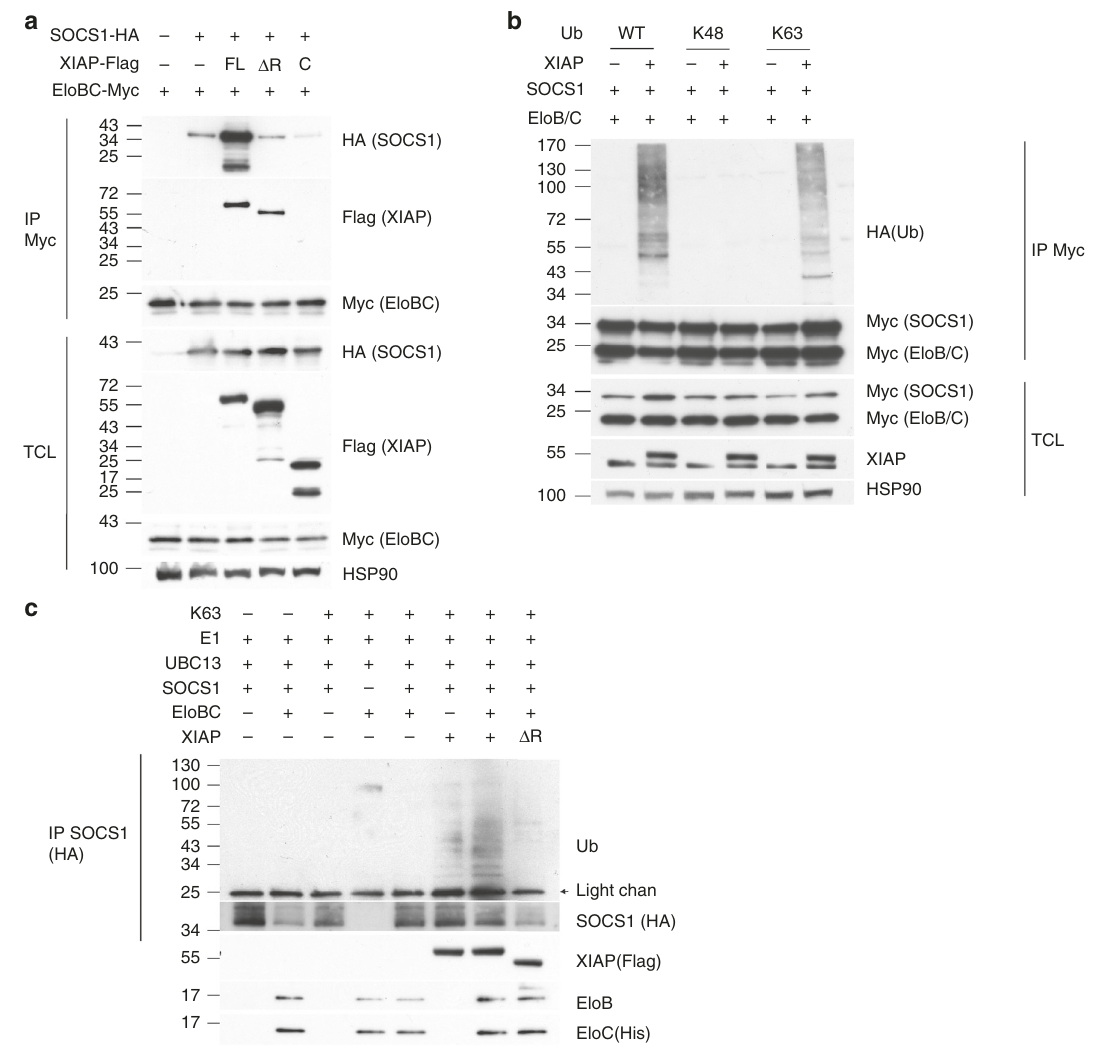
Fig. 4 XIAP enhances the association of Elongin B/C with SOCS1 and promotes SOCS1 K63 ubiquitination. a XIAP increases the association of Elongin B/C with SOCS1. Full-length, Δ RING ( Δ R) or C-terminal (C) XIAP-FLAG was co-transfected with SOCS1-HA and Elongin B/C-Myc into HEK293T cells. Elongin B/C-Myc in cell lysates was pulled down by anti-Myc and the presence of SOCS1 and XIAP in the precipitates and lysates was determined by the respective antibodies. b XIAP enhances the addition of K63 ubiquitin to SOCS1 in vivo. XIAP-FLAG was co-transfected with SOCS1-myc and Elongin B/C- Myc into HEK293T cells, with WT Ub, K48 Ub or K63 Ub, as indicated. SOCS1 was immune-precipitated, and the association of ubiquitin type determined. c XIAP promotes SOCS1 K63 poly-ubiquitination in vitro. Recombinant K63 ubiquitin-HA, E1, E2 (UBC13), SOCS1-HA (on Mag beads), Elongin B/C-Myc, or XIAP-FLAG was added as indicated to a ubiquitination reaction conducted at 30 °C for 1 h. Around 10% of the reaction mixture was used for Western blotting. SOCS1-HA was pulled down from the rest of the reaction mixture and ubiquitination of the SOCS1 complex was determined. Experiments were independently repeated three times ( a , c ) or twice ( b